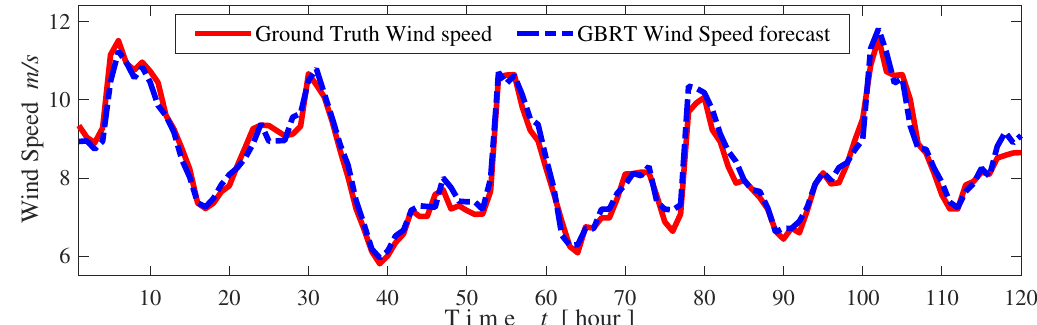
Figure 6. Comparison between the actual versus the predicted wind speed with one-hour-ahead rolling forecasting horizon using the GBRT model at α gbr = 0.1 (from 1/12/2018 to